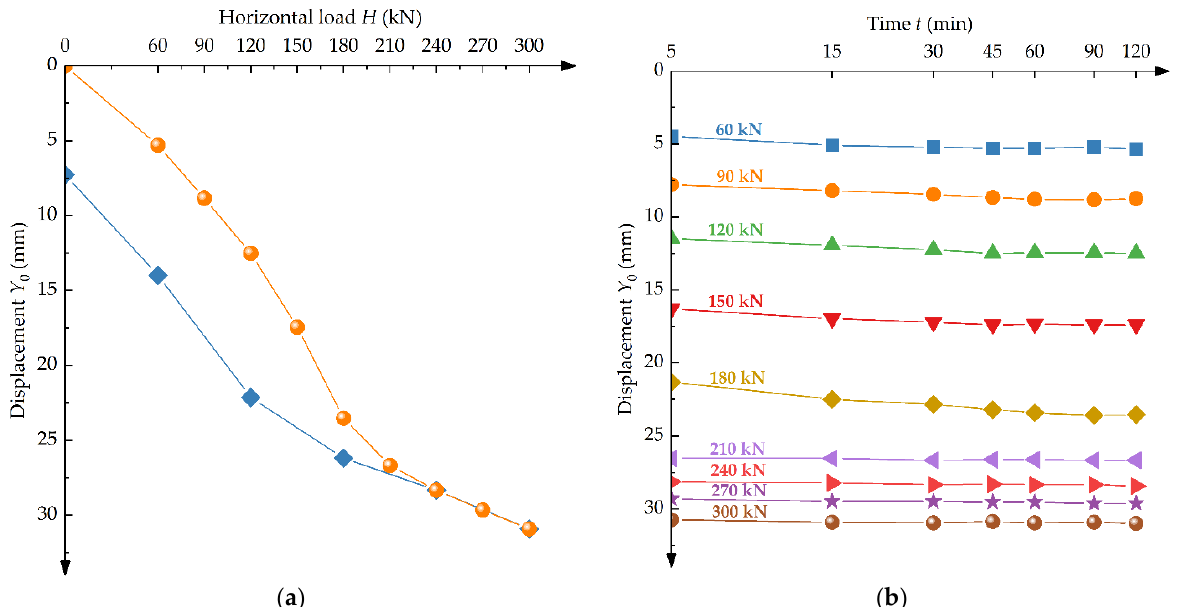
Figure 11. Vertical compressive static load test results of single pile No. 5: ( a ) horizontal load–displacement ( H - Y 0 ) and ( b ) displacement–time logarithm curve ( Y 0 -lg t ).